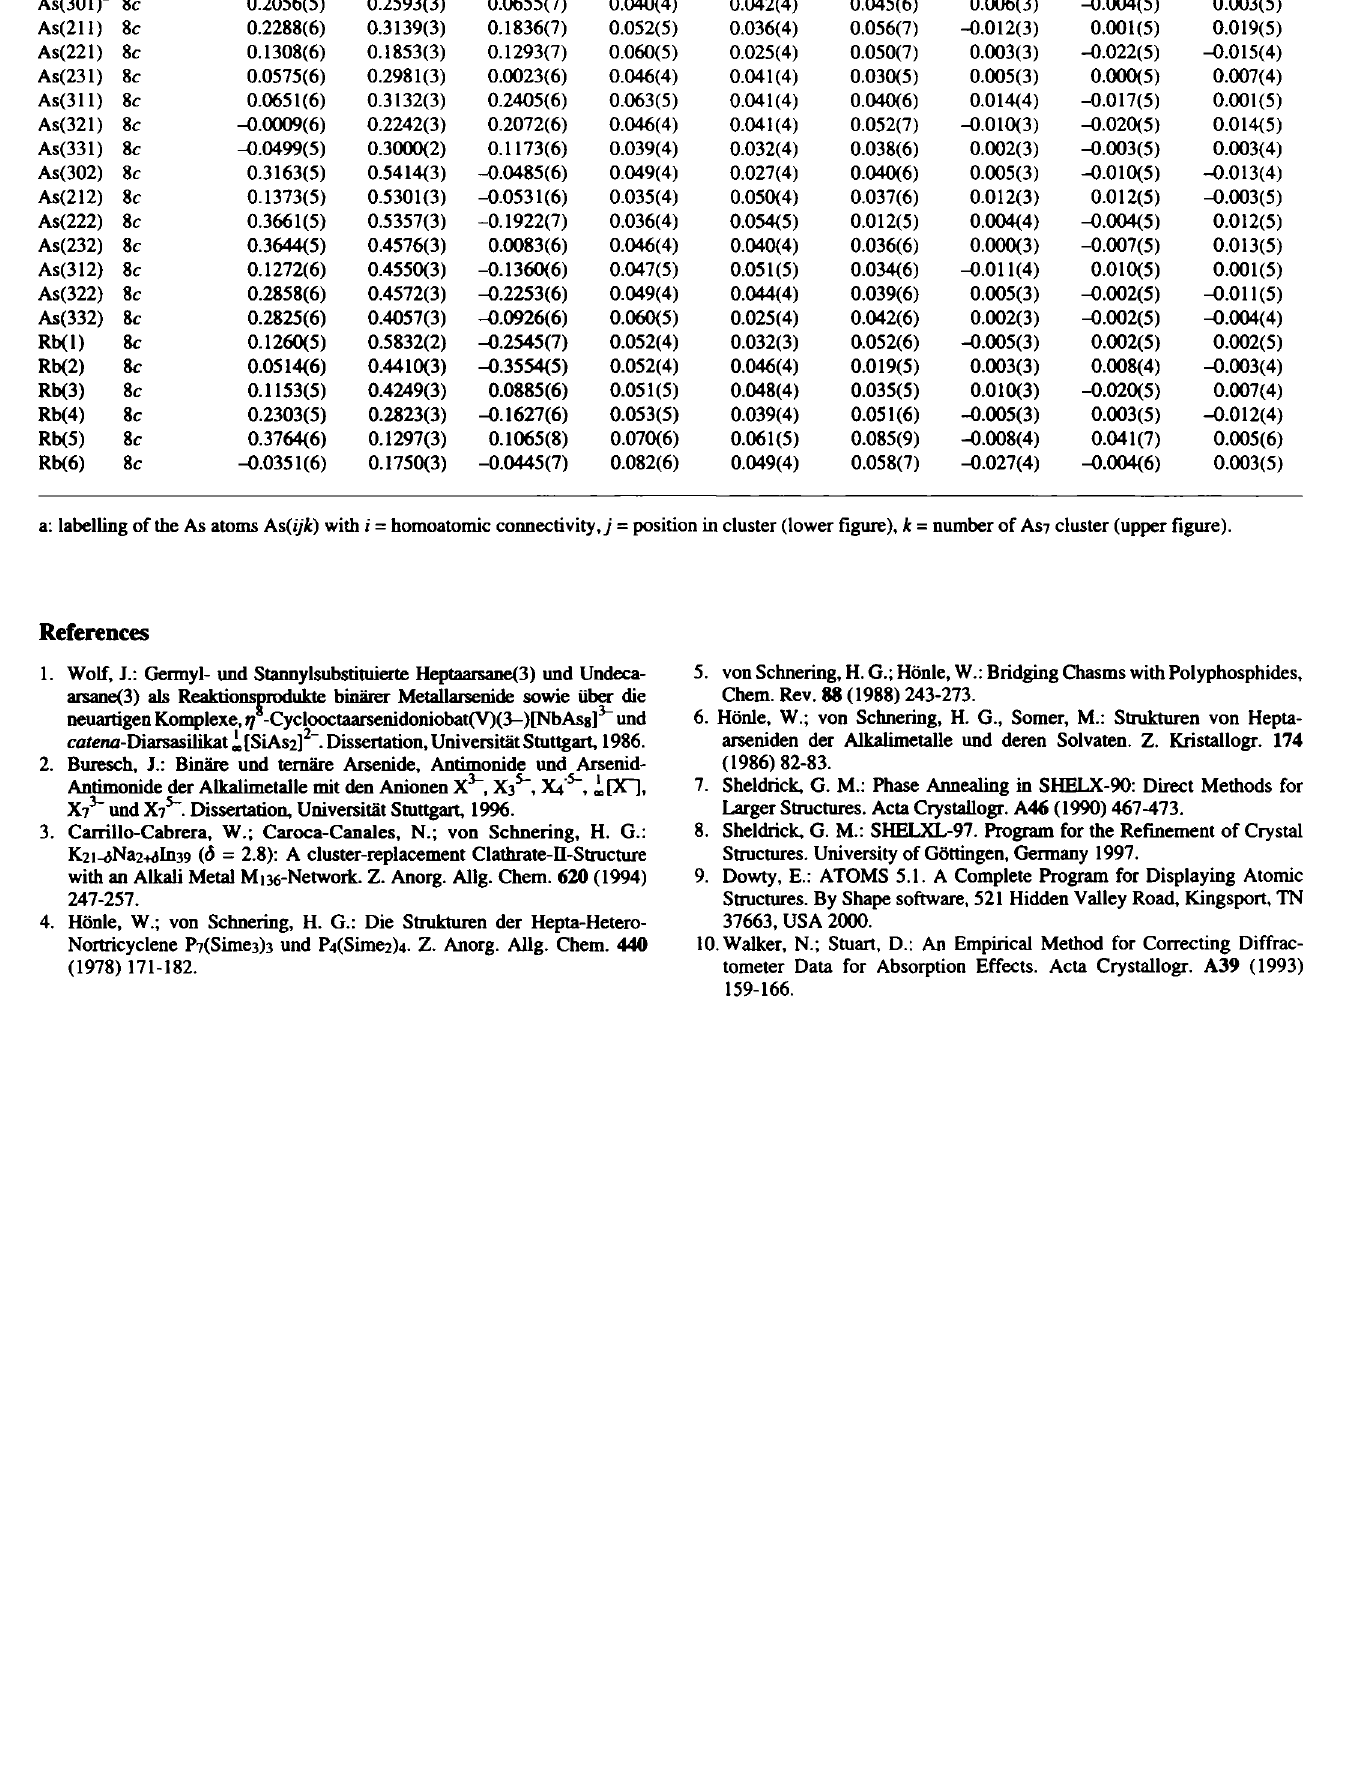
Table 2. Atomic coordinates and displacement parameters (in A 2